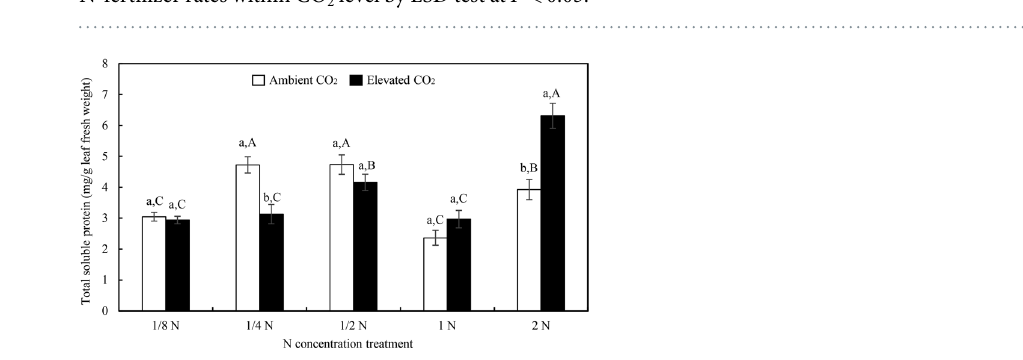
Figure 3. The foliar Bt protein contents of transgenic Bt rice grown under ambient and elevated CO 2 with different N-fertilizer augmentation rates. Different lowercase and uppercase letters indicate significant differences between the ambient CO 2 and elevated CO 2 within N-fertilizer rate, and between the different N-fertilizer rates within CO 2 level by LSD test at P < 0.05.